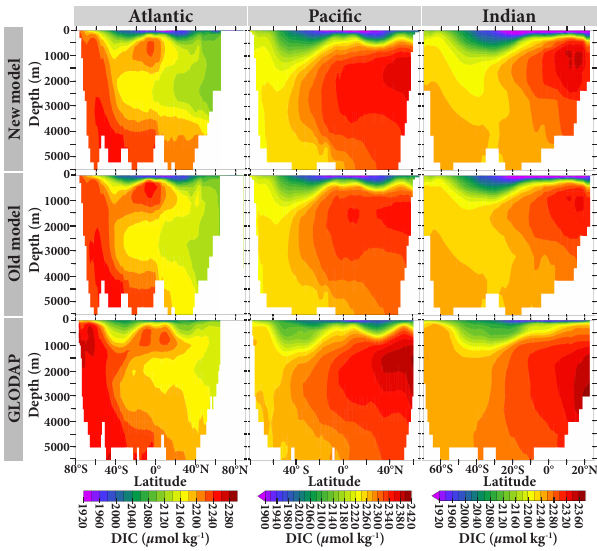
Fig. 5. Zonally averaged ocean basin comparisons of PO 4 between the new and old models and the World Ocean Atlas 2009 data set.